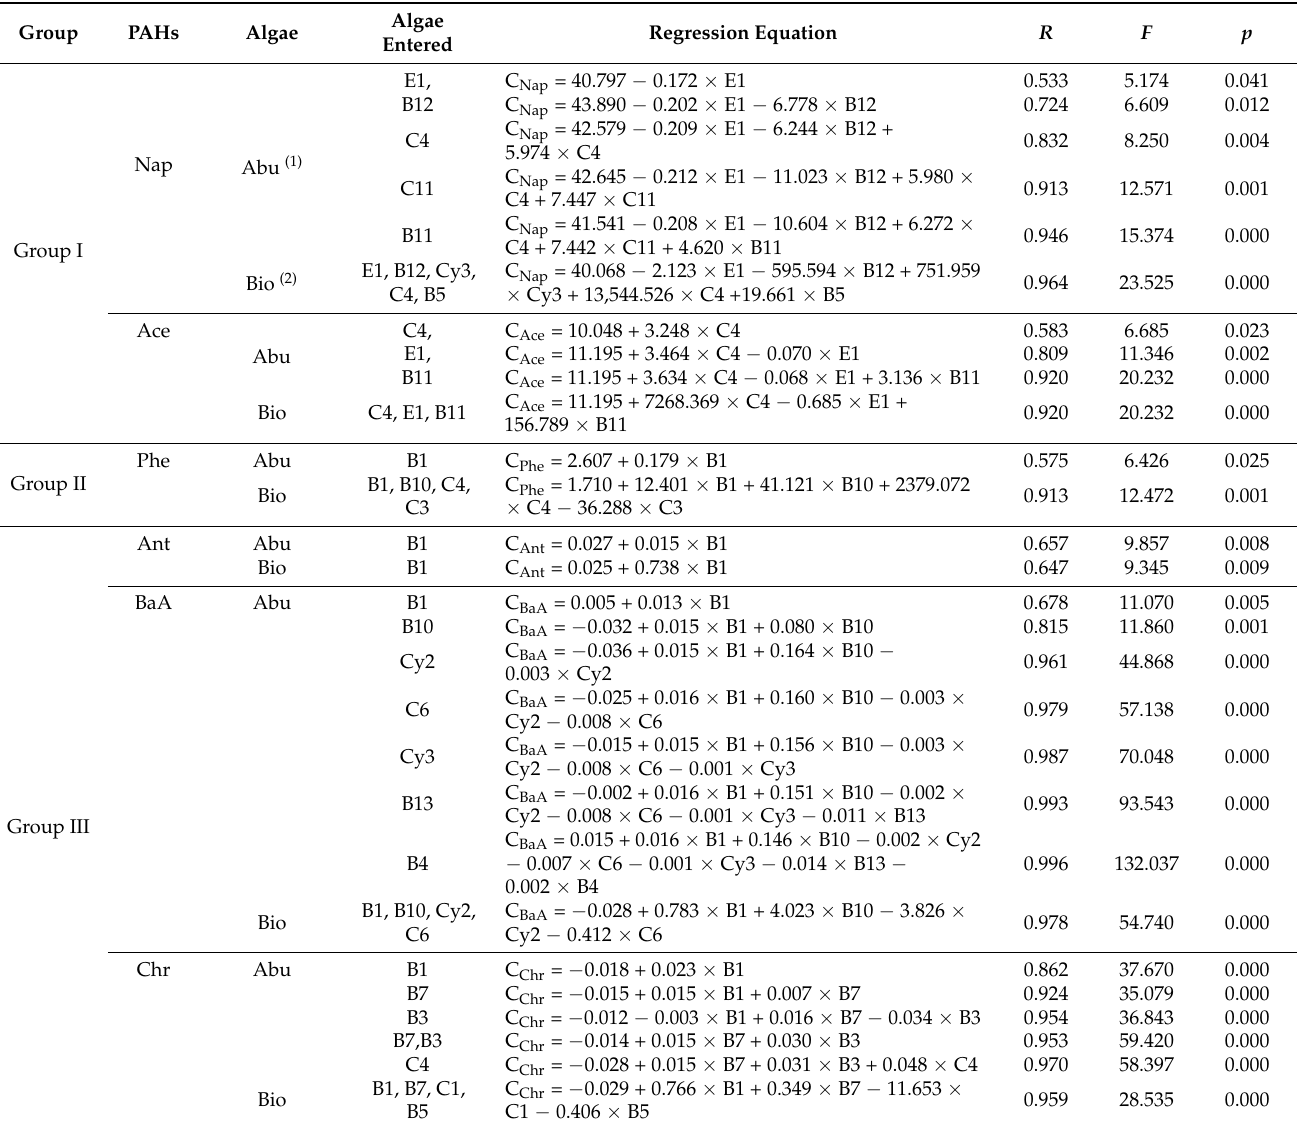
Table 5. Results of stepwise multiple regression between algae abundance/biomass and PAHs